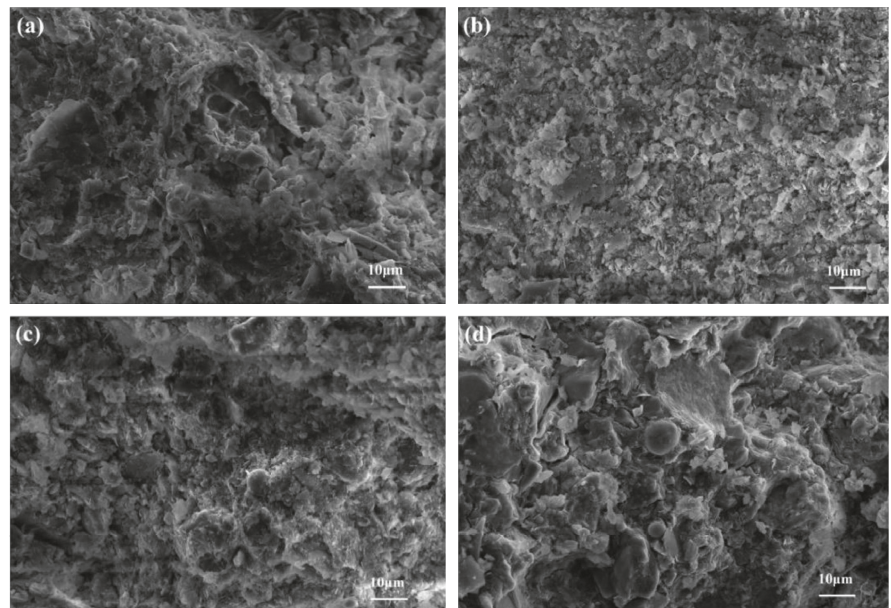
Figure 8: SEM images of dried dredged sludge and solidified sludge after curing for 28 days: (a) dried dredged sludge; (b) with 0% strong oxidant; (c) with 2% GH; (d) with 2% KMnO 4 .